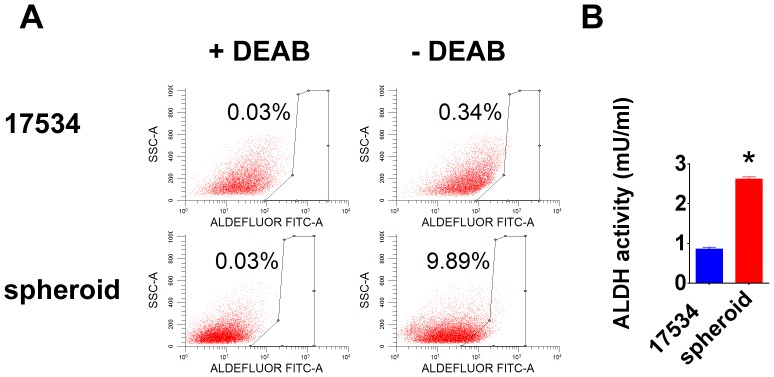
Increased ALDH activity in spheroid cells.(A) The ALDEFLOUR kit labels the population with a high ALDH enzymatic activity in spheroid cells. An aliquot of each sample of cells was treated with ALDH inhibitor DEAB as negative control for setting FACS gate. (B) The BioVision ALDH colorimetric assay detected enhanced ALDH activity in spheroid cell lysate. Error bars: SD, N = 2. *: p<0.05.